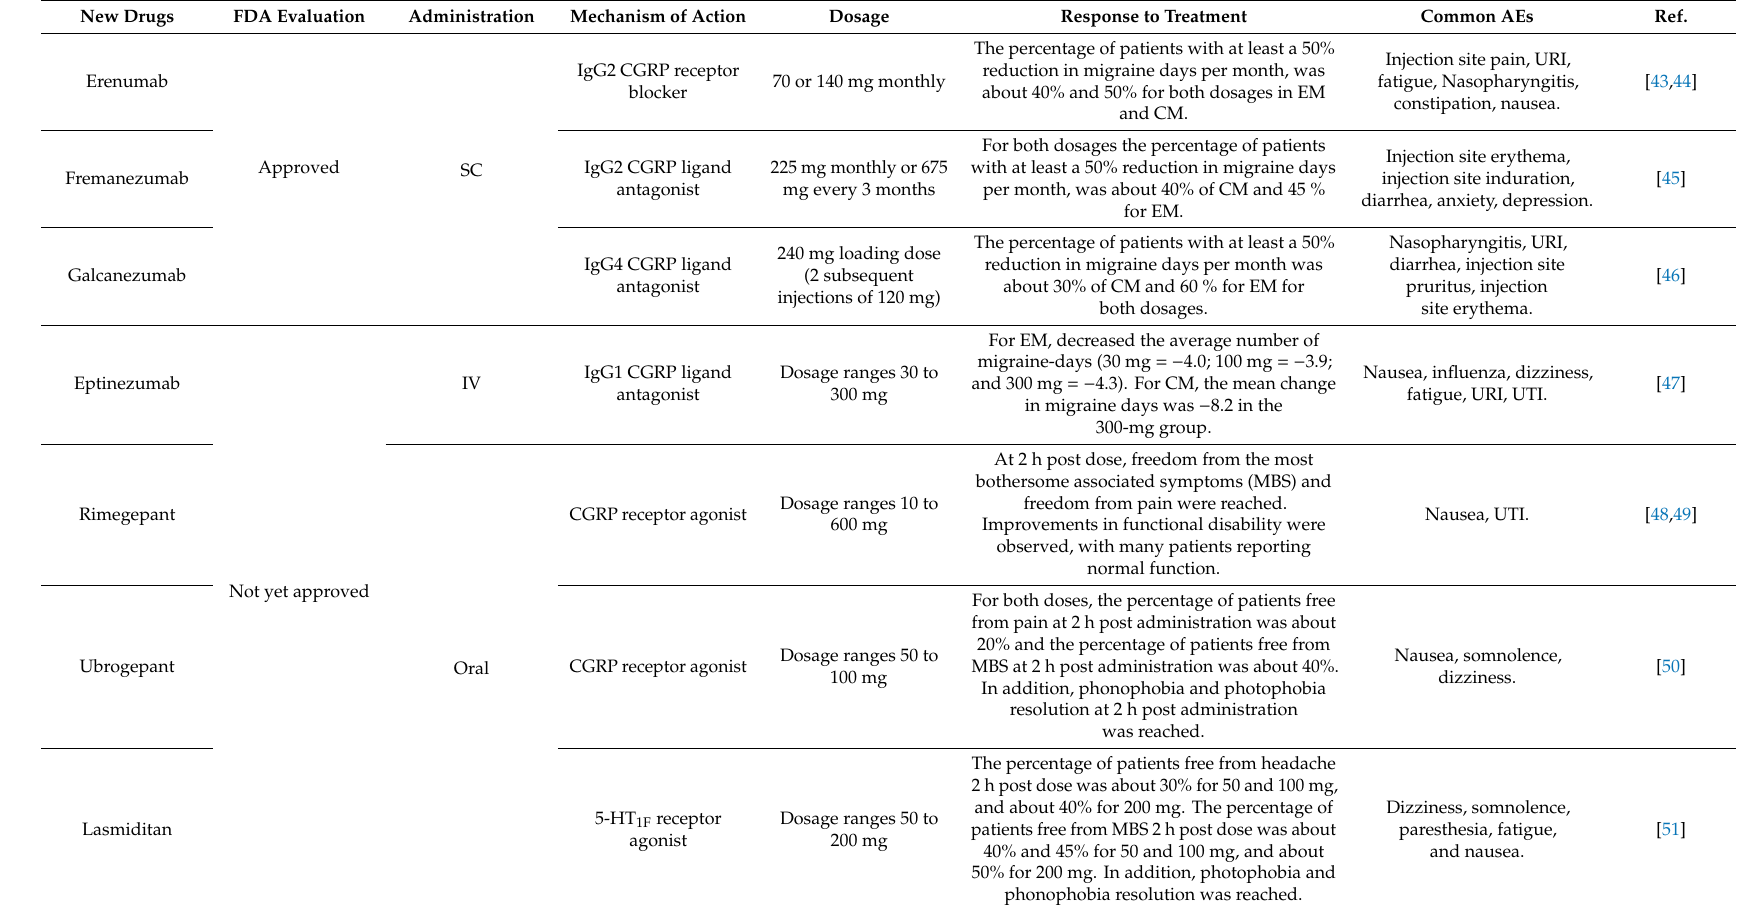
Table 2. New emerging treatments in